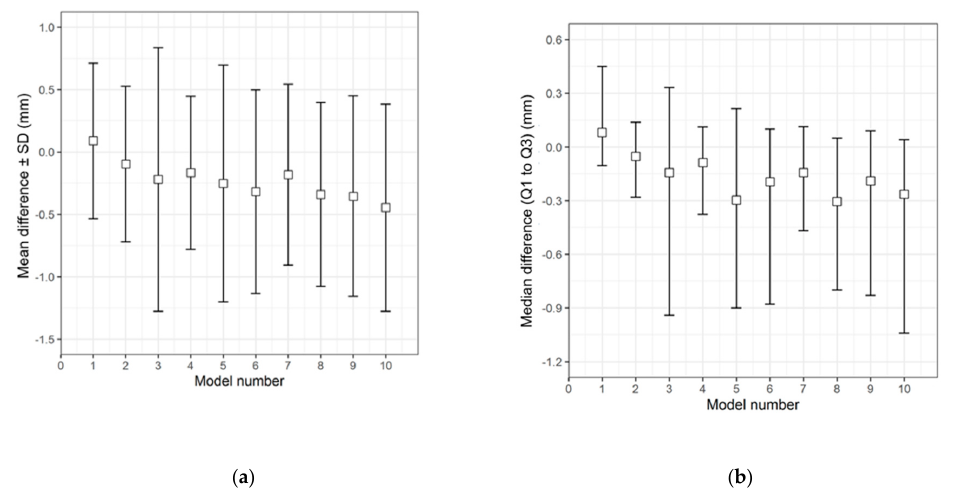
Figure 4. Descriptive data distribution illustrating the di ff erence between the TOD-PSIs (models 1 to 10) and the TOD 3D printed template. ( a ) Mean di ff erence ± SD (mm); ( b ) Median di ff erence (Q1 to Q3)